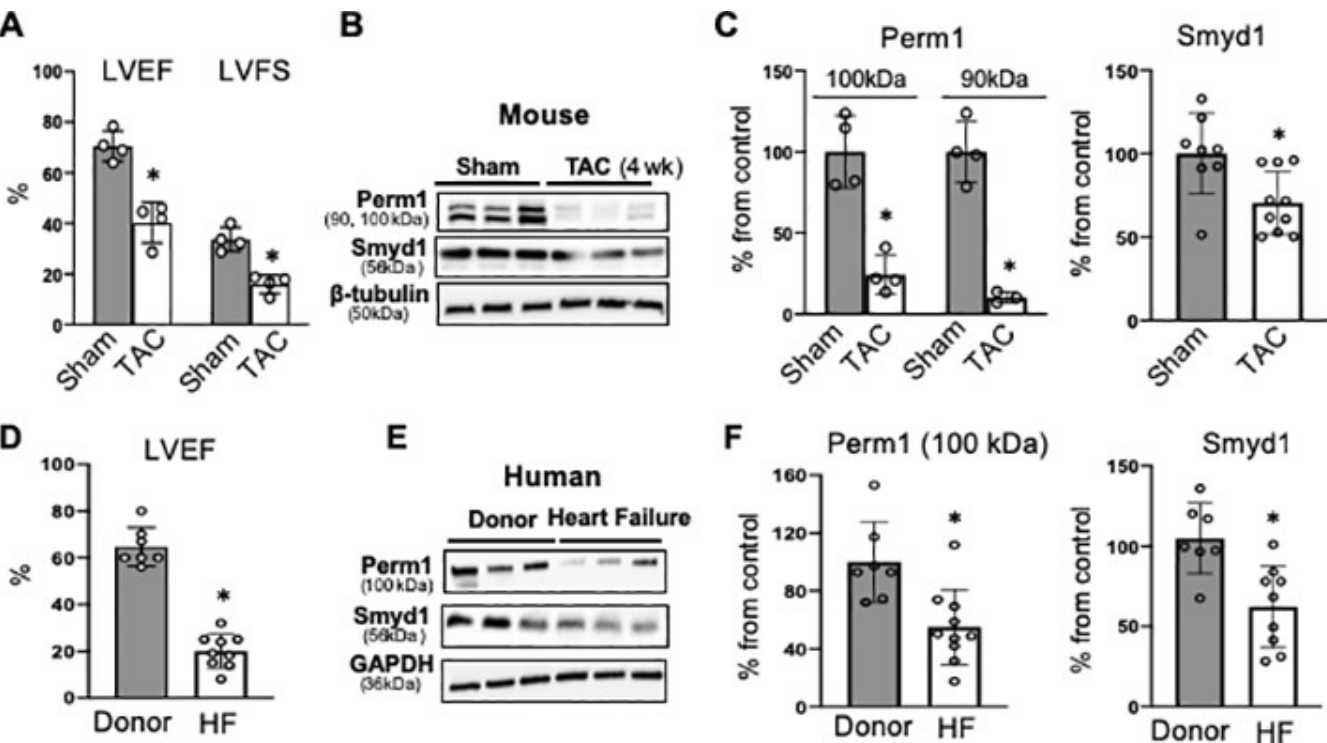
Fig 2. Perm1 is downregulated in the failing heart. (A-C) Downregulation of Perm1 and Smyd1 in mouse hearts subjected to TAC surgery for 4 weeks, where left ventricular ejection fraction (LVEF) and fractional shortening (LVFS) were significantly decreased as compared with sham-operated hearts (n = 4/group for Perm1 expression, n = 8-10/group for Smyd1 expression) (also see S1 Table). Consistent with previous studies in the mouse skeletal muscle [10, 25, 26], Western blotting analysis shows two isoforms of Perm1 at 90 kDa and 100 kDa in the mouse heart ( Panel B ). ( D-F) Downregulation of Perm1 and Smyd1 in patients with heart failure, where LVEF was significantly decreases as compared with donor hearts (n = 7 in donor group, n = 9–10 in heart failure patients, also see S2 Table). Statistics were performed using the t-test with 2 tails. � : p < 0.05. Error bars are ± SEM.